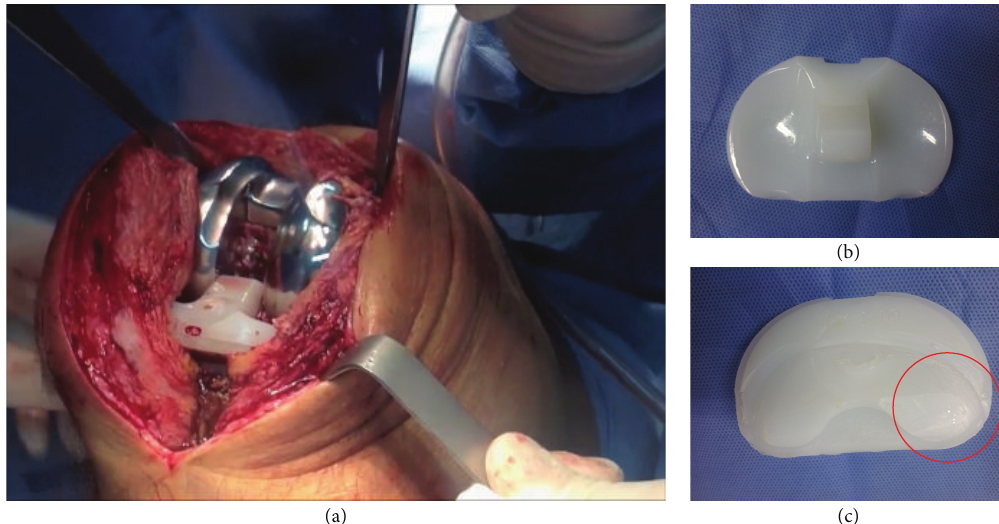
Figure 2: Intraoperative image (a) showing tibial insert dislodgment after an anterior approach of the right knee. Images of the superior (b) and inferior (c) aspects of the retrieved tibial polyethylene evidencing indemnity of the former and damage at the posteromedial zone of the latter